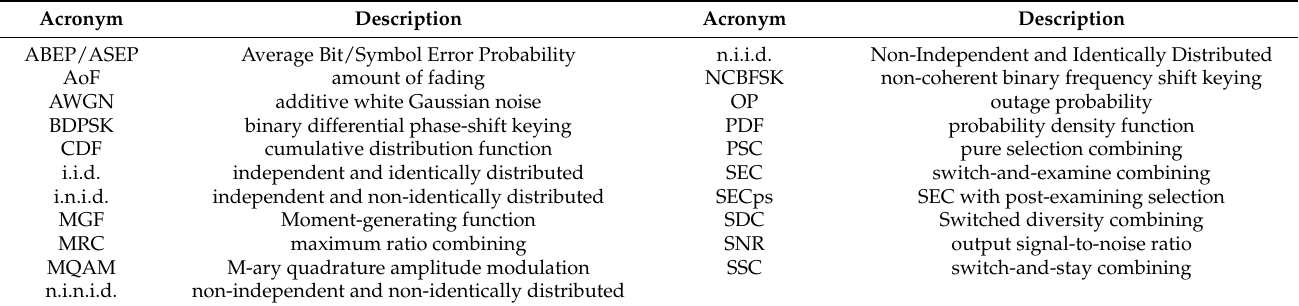
Table 2. A list of acronyms used in this